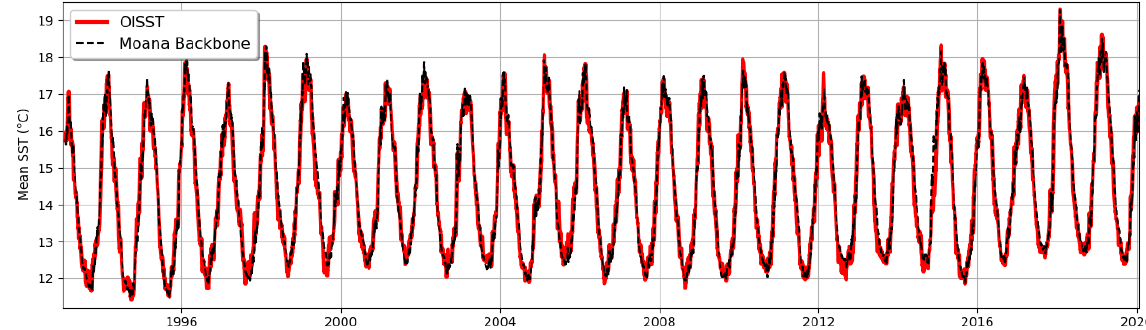
Figure 5. Domain-averaged SST ( ◦ C) for the Moana Ocean Hindcast and the OISST observational product. The Moana Ocean Hindcast model is able to reproduce the observed SST variability ranging from sub-seasonal to inter-annual.